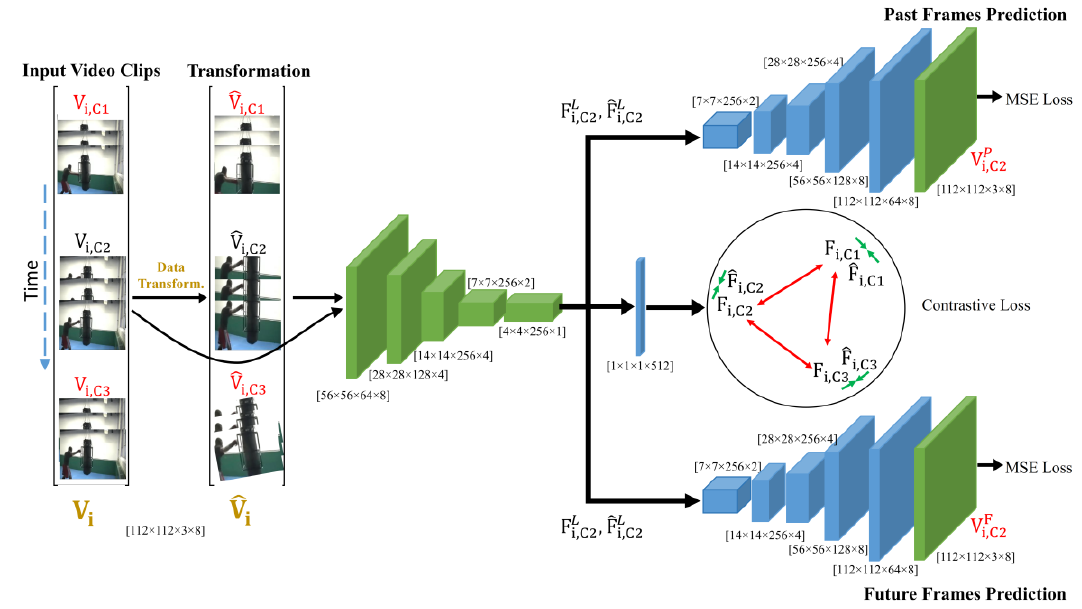
Figure 1. Overview of proposed Approach. (The red arrow indicates repulsion and the green arrow indicates